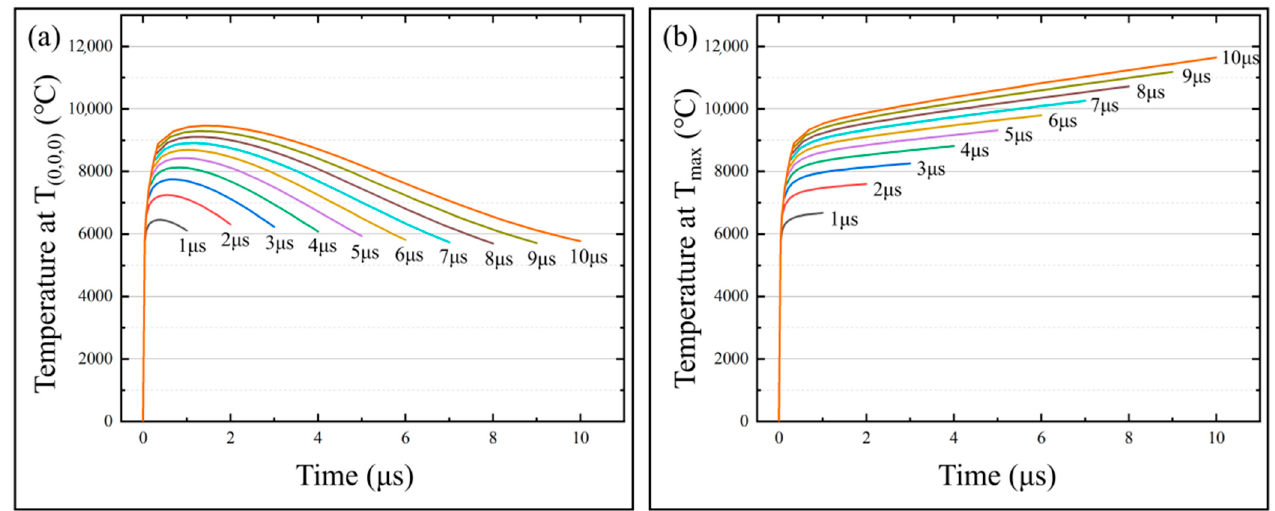
Figure 12. ( a ) T (0,0,0) variation with machining time at different pulse widths; ( b ) T max variation with machining time at different pulse widths.